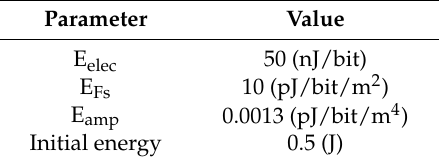
Table 1. Default value of all network parameters used in the